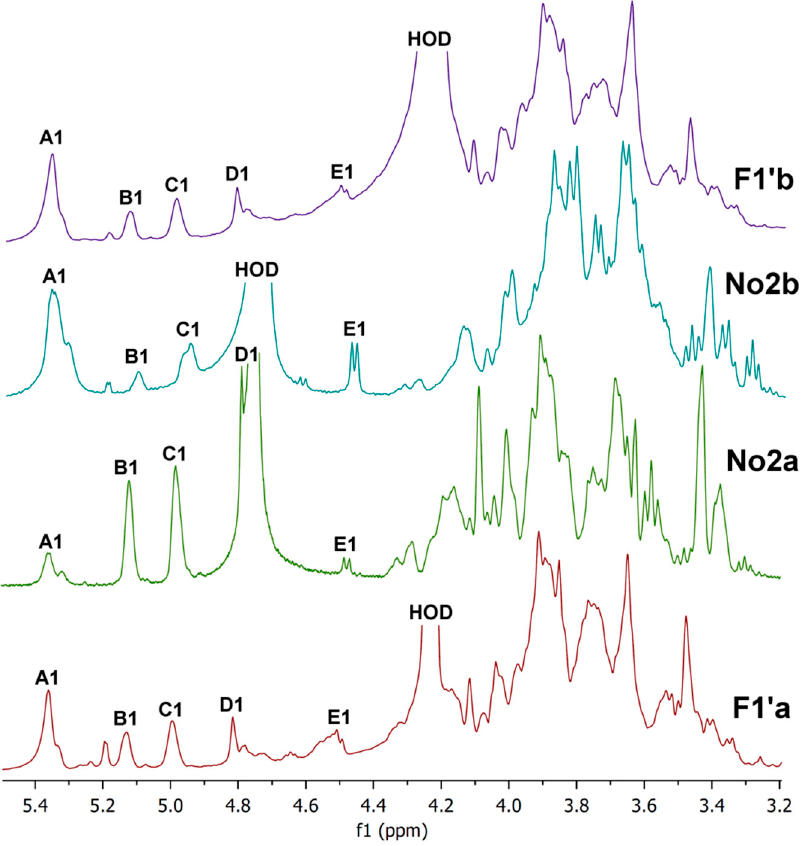
Figure 8. Proton NMR spectra (D 2 O, 20 °C and 80 °C) of cold-water-soluble ( F1 ′ a ) and cold-water-insoluble ( F1 ′ b ) parts and sub-fractions No2a and No2b of hot water extract F1 ′ obtained from basidiocarps of P. ostreatus .